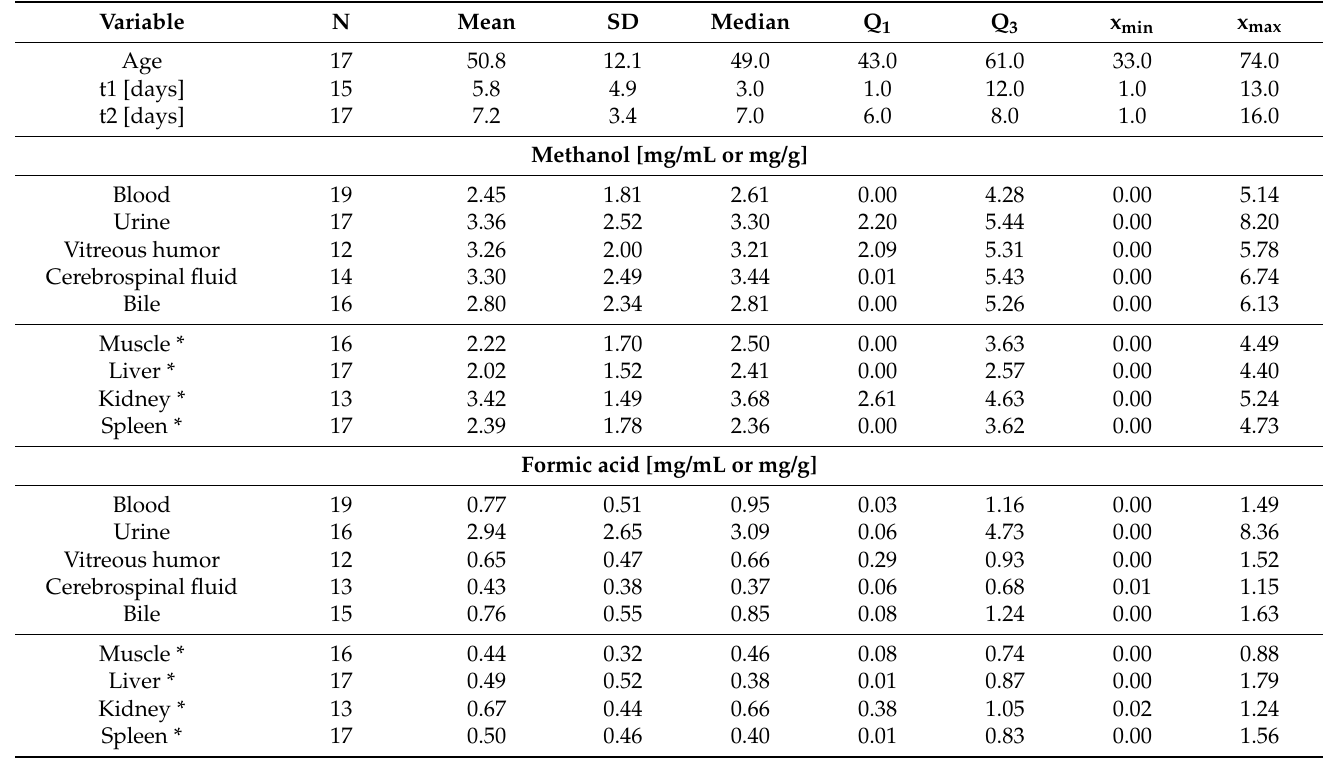
Table 1. Descriptive statistics of quantitative variables analyzed in the victims of fatal methanol poisoning (N =